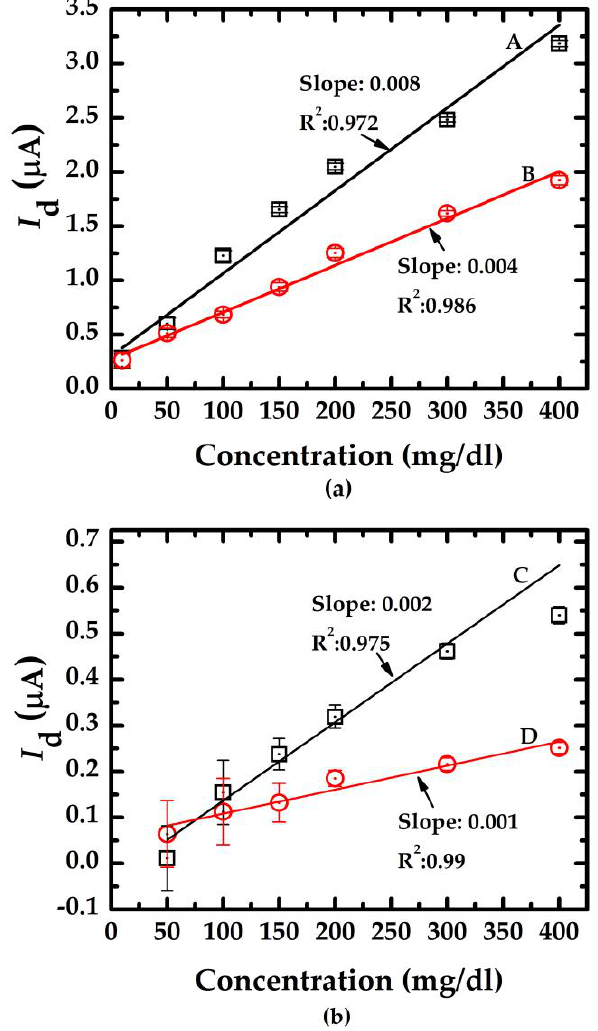
Figure 10. The calibration curves of the salt concentration measurement of the doped/undoped poly-silicon nanowire sensors. ( a ) doped type NWGS with lengths of 3.5 µ m (A) and 5.3 µ m (B); ( b ) undoped type NWGS with lengths of 3.5 μ m (C) and 5.3 μ m (D). Resolution of the proposed method can be represented as [26]